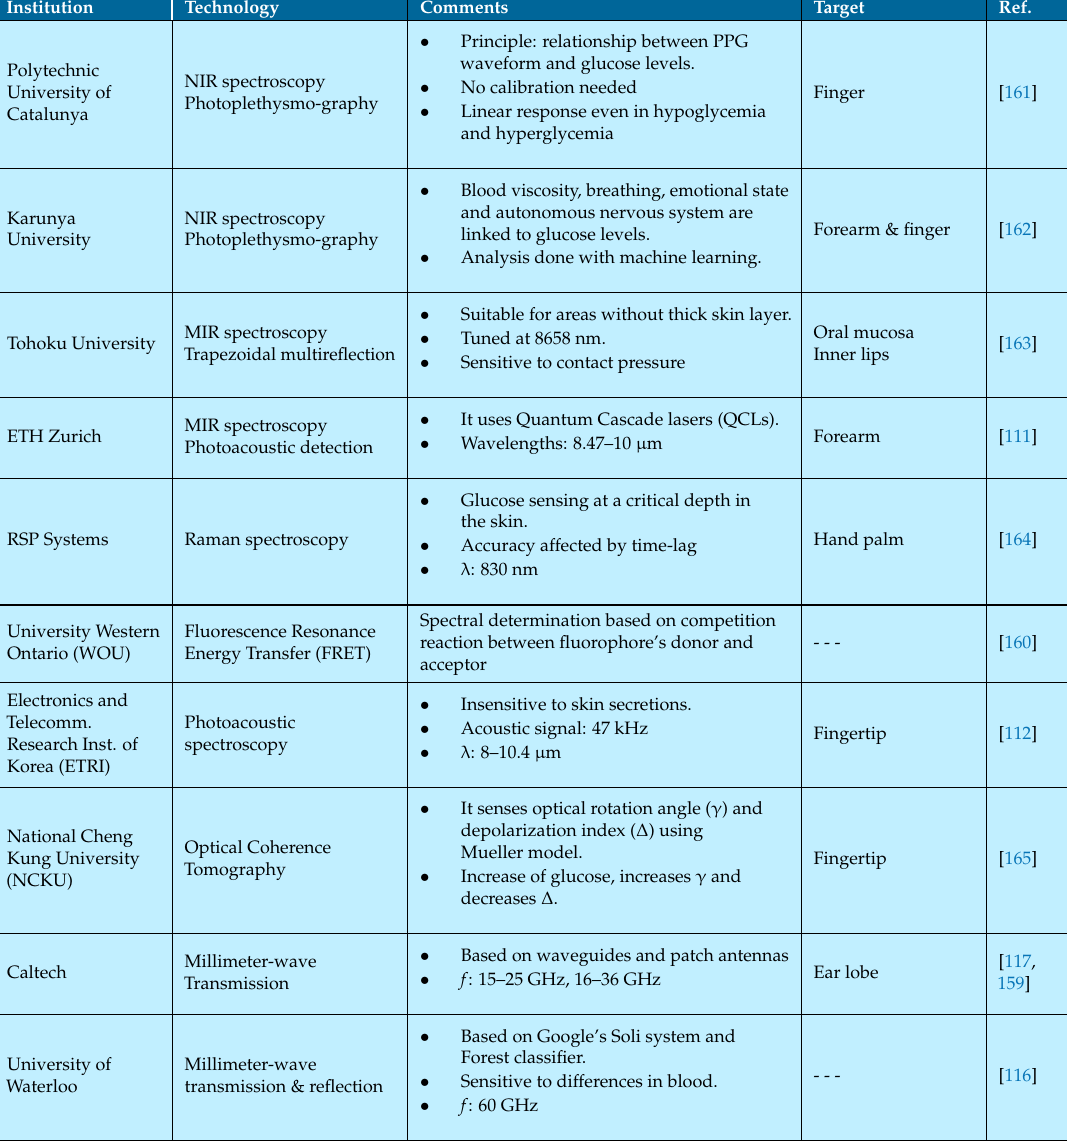
Table 25. List of current research on NI and MI technologies for glucose